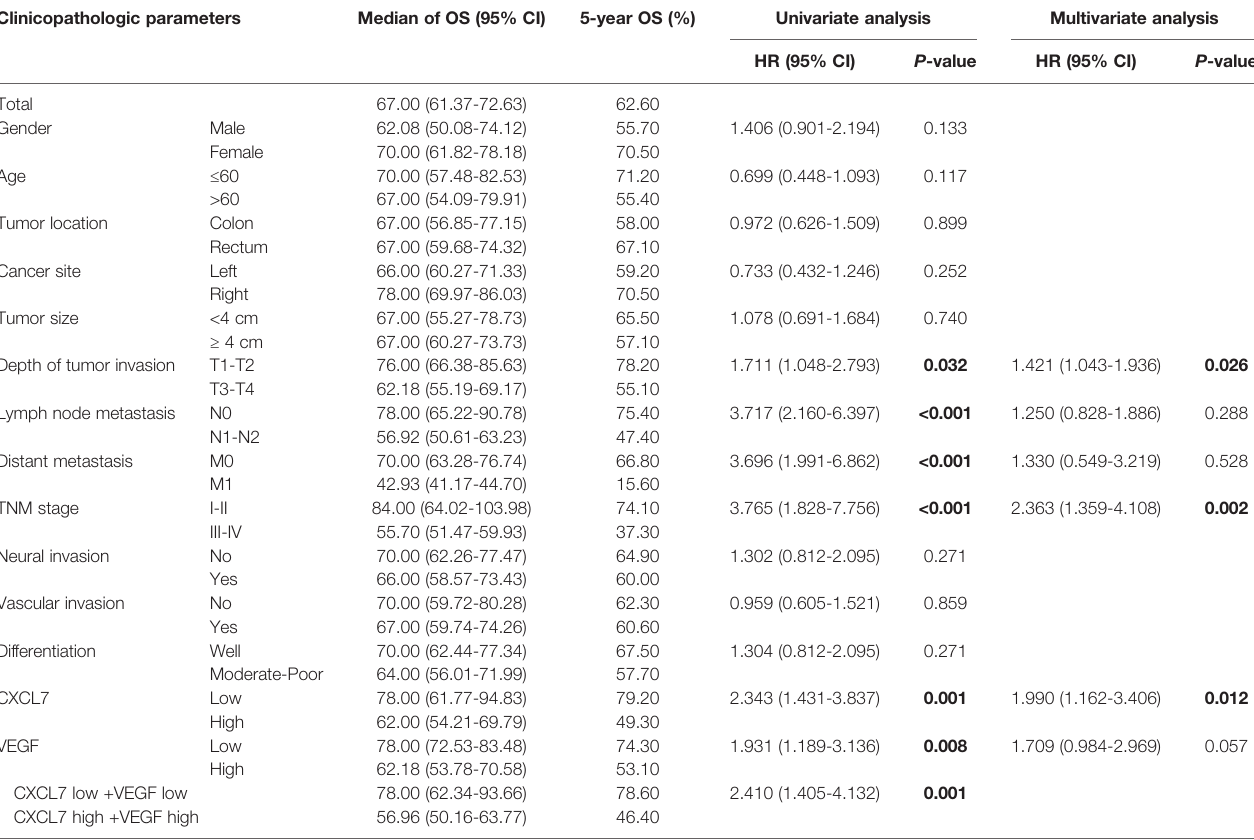
TABLE 2 | Cox proportional hazard regression models for CXCL7, VEGF and clinical pathological characteristics. Clinicopathologic